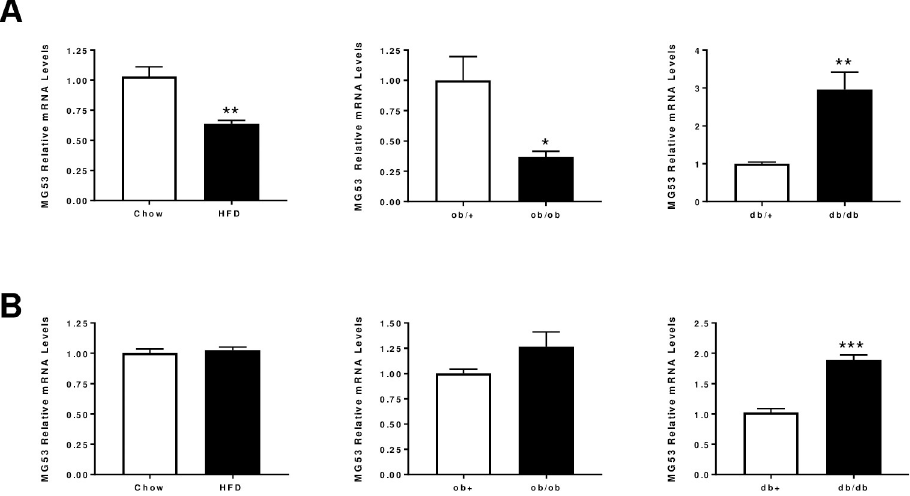
Fig 1. MG53 mRNA levels in skeletal muscles from various preclinical models of insulin resistance. MG53 relative mRNA levels in gastrocnemius (Panel A) or soleus (Panel B) from various preclinical models of insulin resistance: High fat diet (60% fat for 12 weeks), ob/ob (10-week old) and db/db (10-week old). Data are expressed as means ± SEM (n = 10 per group; � : p < 0.05, �� : p < 0.01, ��� : p < 0.001 diseased vs . control).